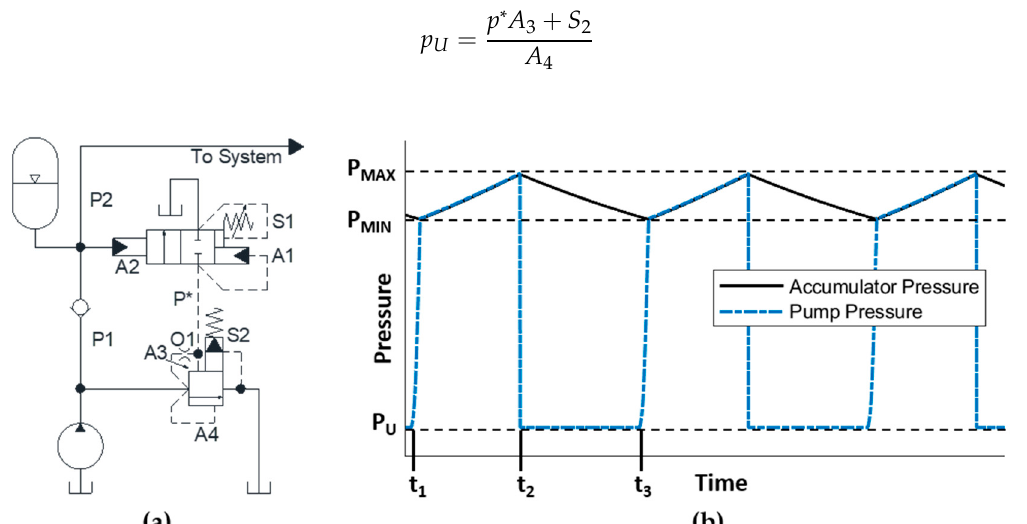
Figure 2. ( a ) Accumulator-sense pump-unloading (ASPU) valve, ( b ) duty cycle representation.